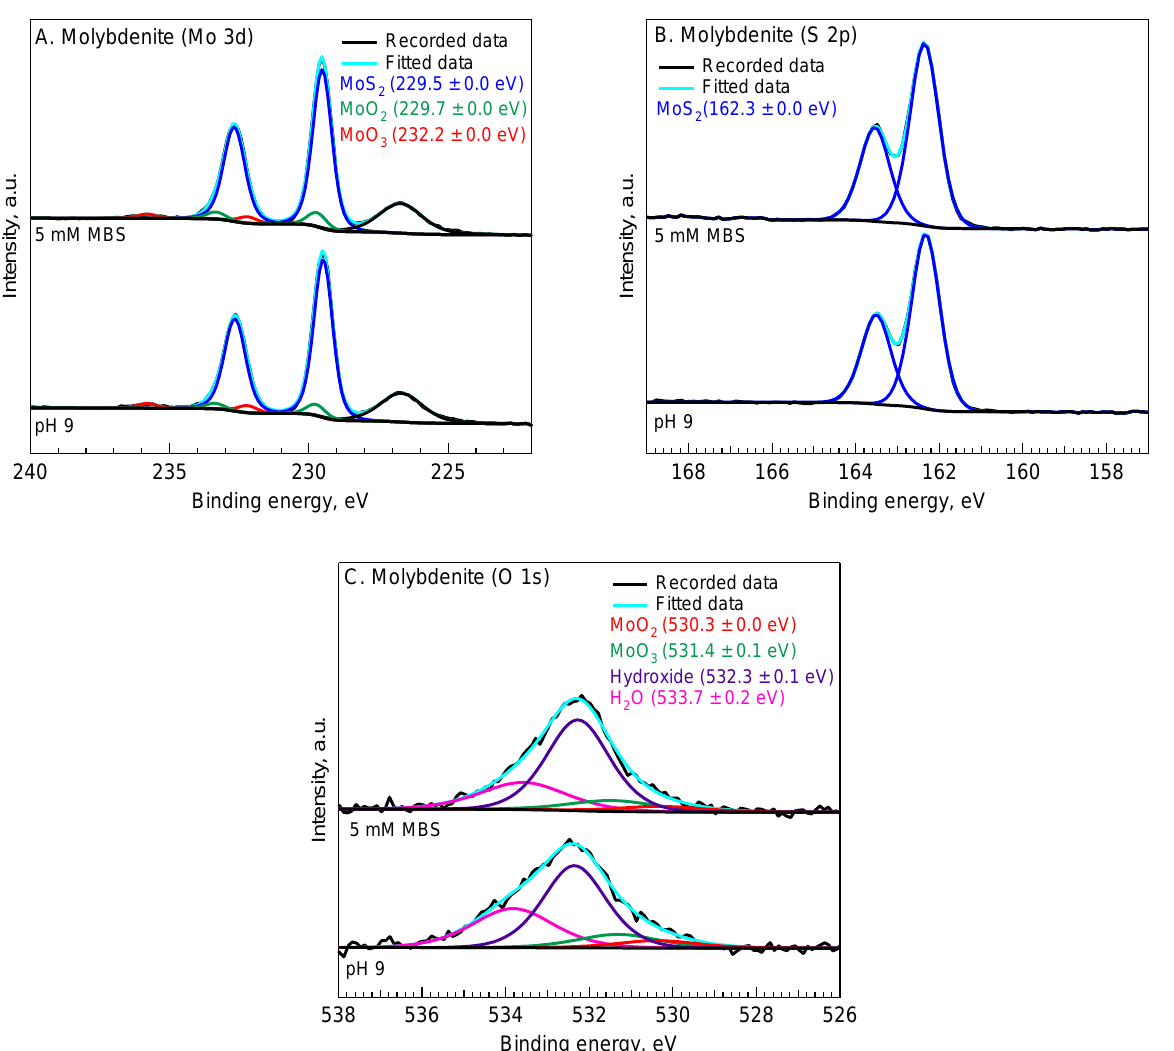
Figure 4. Mo 3d ( A ), S 2p ( B ), O 1s ( C ) spectra of chalcopyrite without and with 5 mM MBS treatment at pH 9.